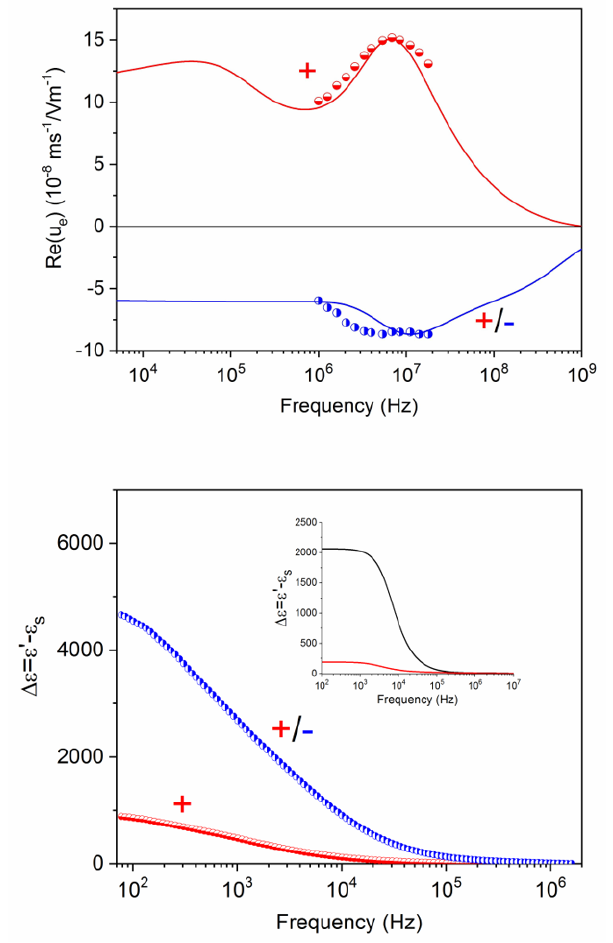
Figure 11. Same as Figure 10, but for latex particles coated with PDADMAC (+) and PDADMAC/PSS (+/ −